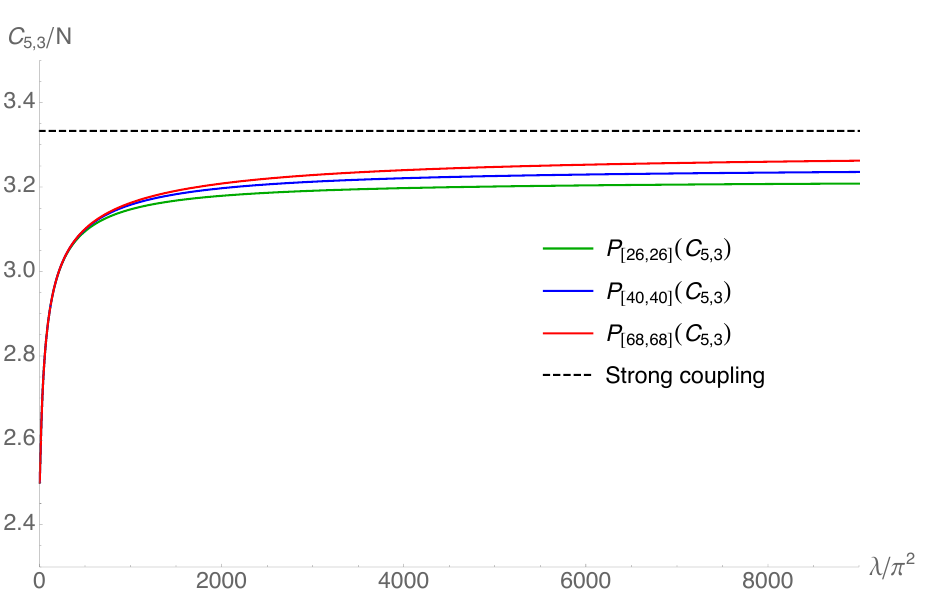
( C 5 , 3 ) for M = 26 (green curve), M = 40 [ M/M ]